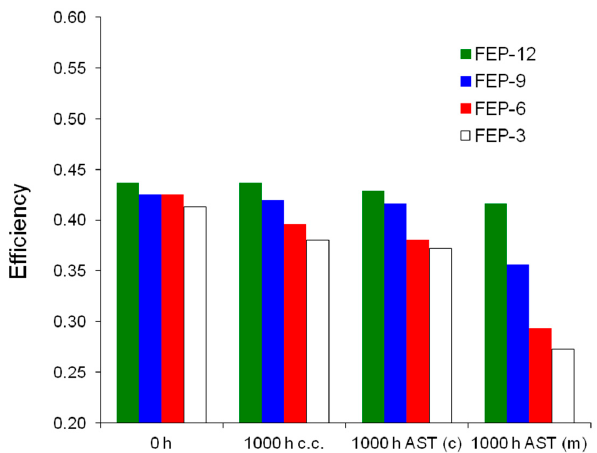
Figure 8. Global efficiencies obtained for fuel cells assembled with fresh (0 h, not stressed), constant current (c.c.) aged, chemically (AST (c)) and mechanically (AST (m)) stressed FEP-based GDMs.